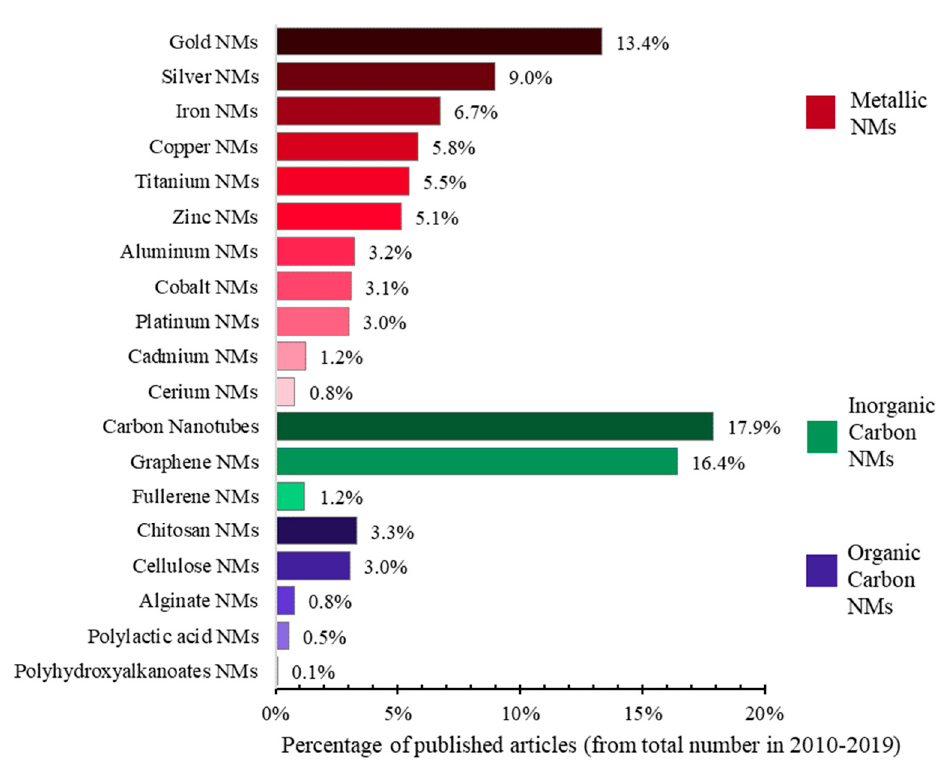
Figure 5. Bibliometric analysis of research on various types of nanomaterials in 2010–2019 from Web of Science Core Collection ( Web of Science, Clarivate Analytics), the search strategy used to retrieve the data being: TS = (Nano* AND polyhydroxyalk*), TS = (Nano* AND polylact*), TS = (Nano* AND algin*), TS = (Nano* AND cellulos*), TS = (Nano* AND Chitosan*) TS = (Nano* AND fuller*), TS = (Nano* AND graphen*), TS = (Nanotub* AND carbon*), TS = (Nano* AND cerium*), TS = (Nano* AND cadmium*), TS = (Nano*ANDplatinum*), TS = (Nano*ANDcobalt*), TS = (Nano*ANDaluminum*), TS = (Nano*AND zinc*), TS = (Nano* AND titanium*), TS = (Nano* AND copper*), TS = (Nano* AND iron*), TS = (Nano* AND silver*) and TS = (Nano* AND